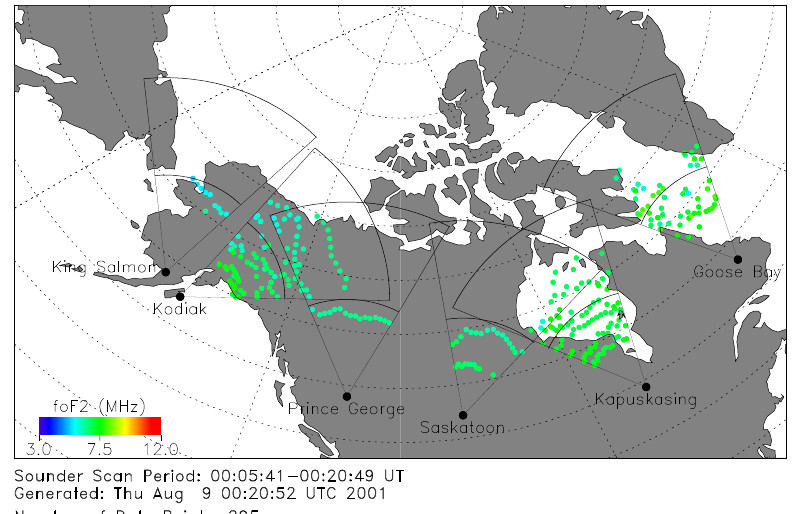
Fig. 5. Critical frequencies computed using real-time SuperDARN data. The colored circles show locations corre- sponding to half the skip distance ob- served for each frequency and beam di- rection with the color scale indicating the F-region critical frequency at that